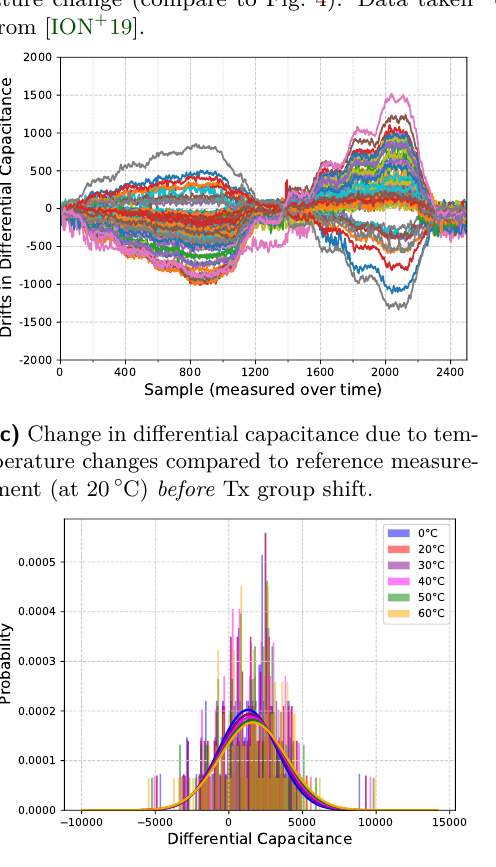
(b) Differential capacitance under temperature change after Tx group shift.